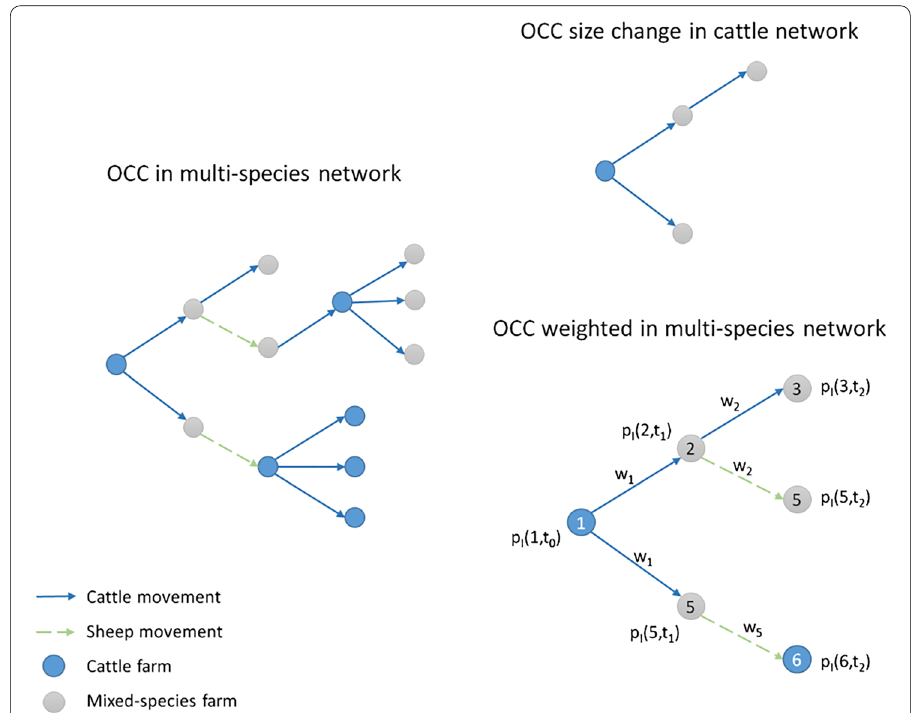
Fig. 4 Schematic representation of Outgoing Contact Chains in the multi‑species and cattle networks, and the network with weighted